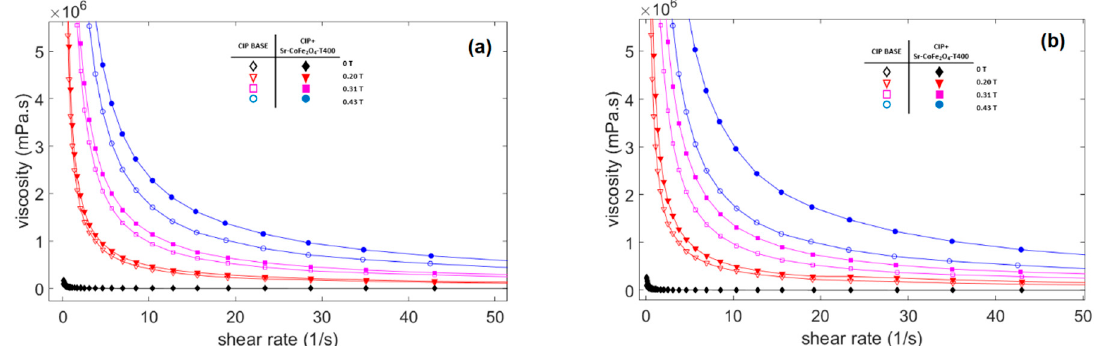
Figure 6. Viscosity curve of MRF samples against shear rate at different magnetic fields ( a ) Comparison between MRF CIP-base and MRF CIP+Sr-CoFe 2 O 4 -T300 ( b ) Comparison between MRF CIP-base and MRF CIP+Sr-CoFe 2 O 4 -T400.